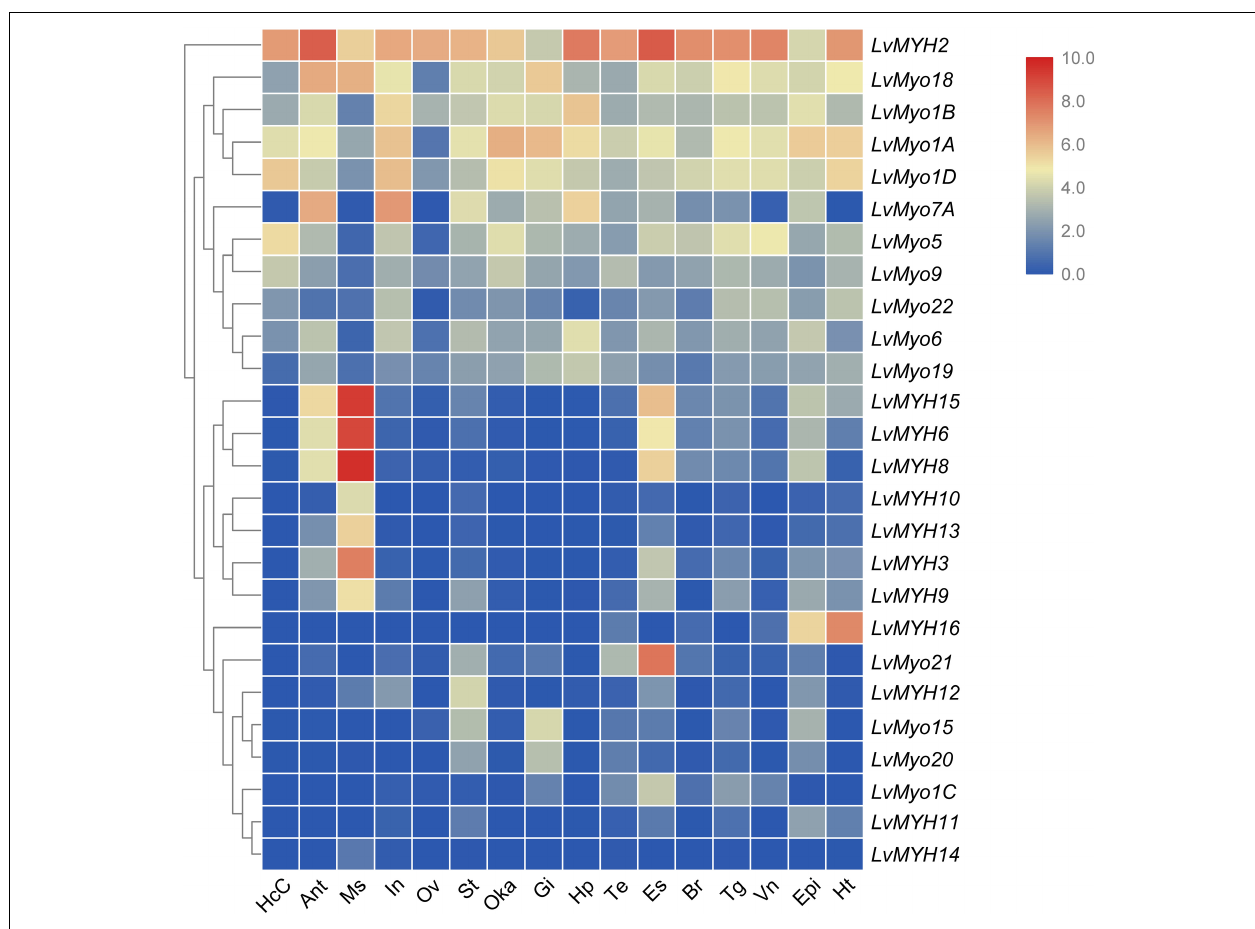
FIGURE 7 | The expression profiles of myosin genes in 16 adult tissues. Log2-transformed expression values were used to create the heat map. The red or blue colors represent the higher or lower relative abundance of each myosin gene, respectively. To the left are myosin genes; the top lists the adult tissues of L. vannamei . (HcC, hemocyte cells; Ant, antennary gland; Ms, abdominal muscle; In, intestine; Ov, ovary; St, stomach; Oka, lymphoid organ; Gi, gill; Hp, hepatopancreas; Te, testis; Es, eyestalk; Br, brain; Tg, thoracic ganglion; Vn, ventral nerve; Epi, epidermis; Ht,